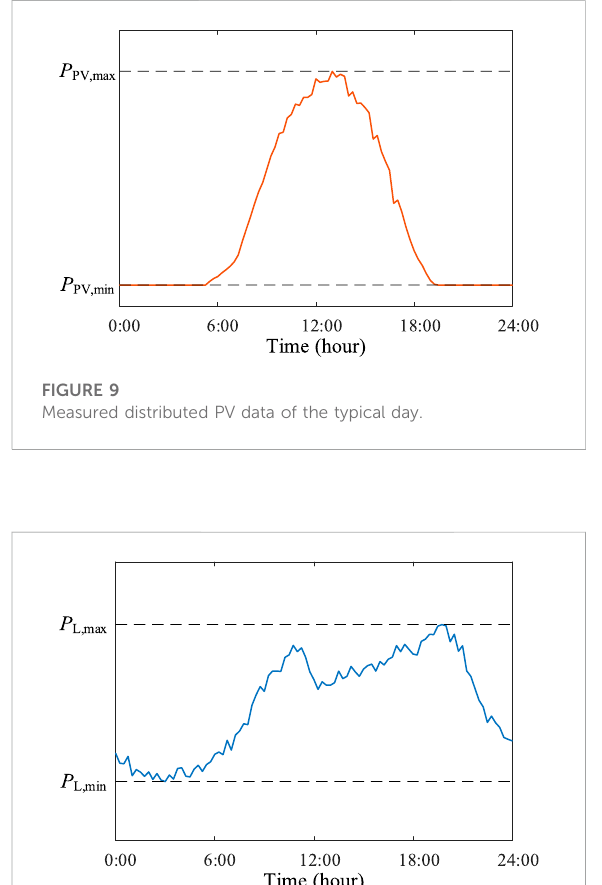
FIGURE 10 Measured electrical load data of the typical day.